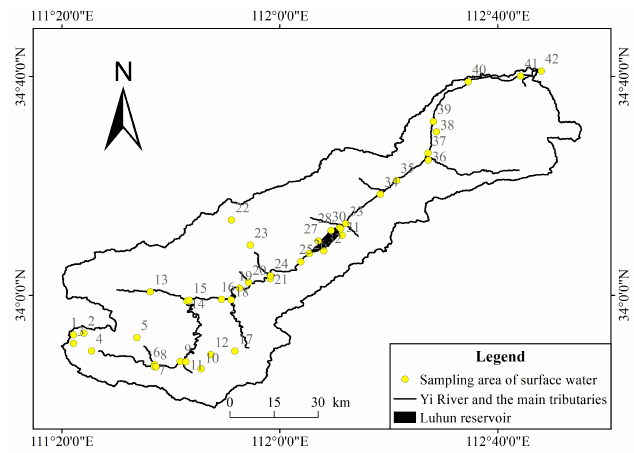
Figure 3. Surface water sampling sites.